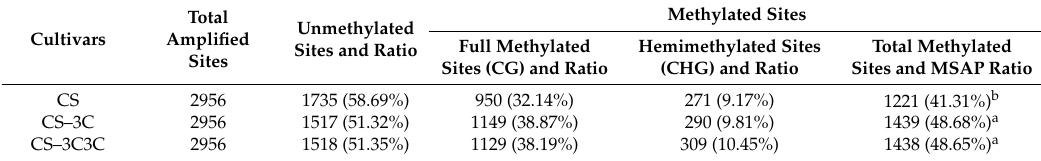
Table 2. Patterns of genomic DNA cytosine methylation in anthers of CS, CS–3C and